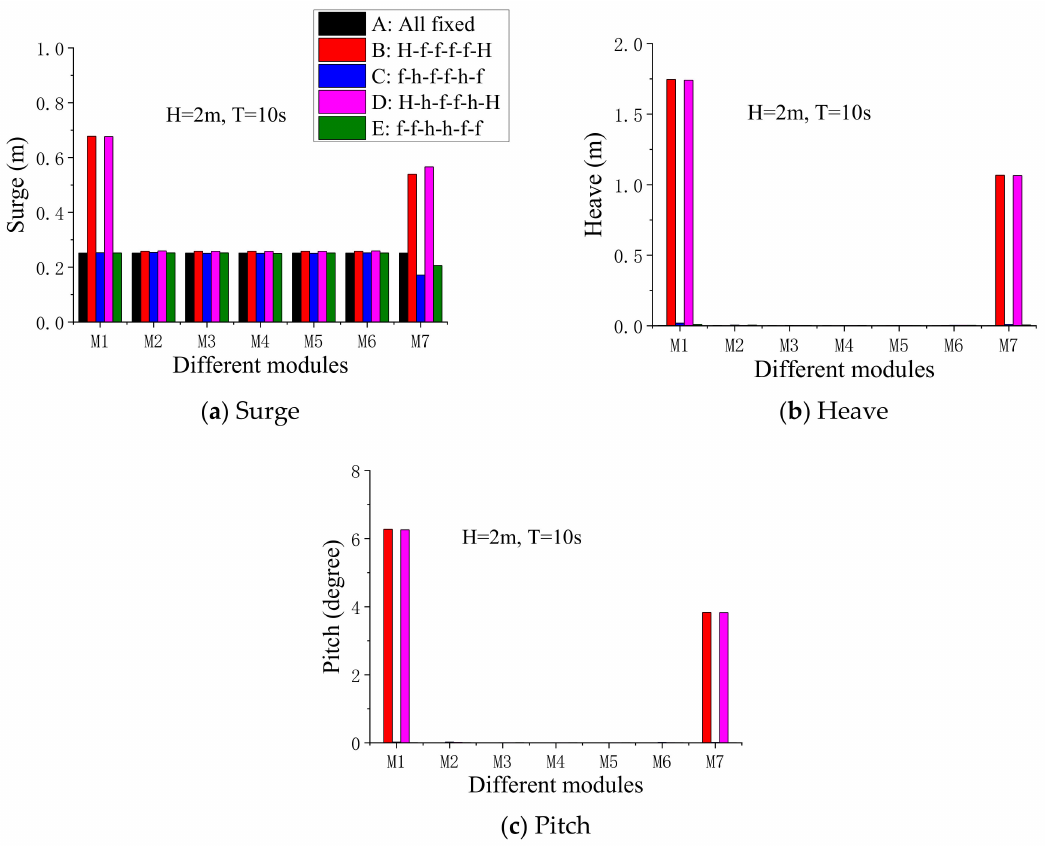
Figure 5. Main motion responses of the seven-module MTLPW system with different connection modes: ( a ) Surge, ( b ) heave, ( c )